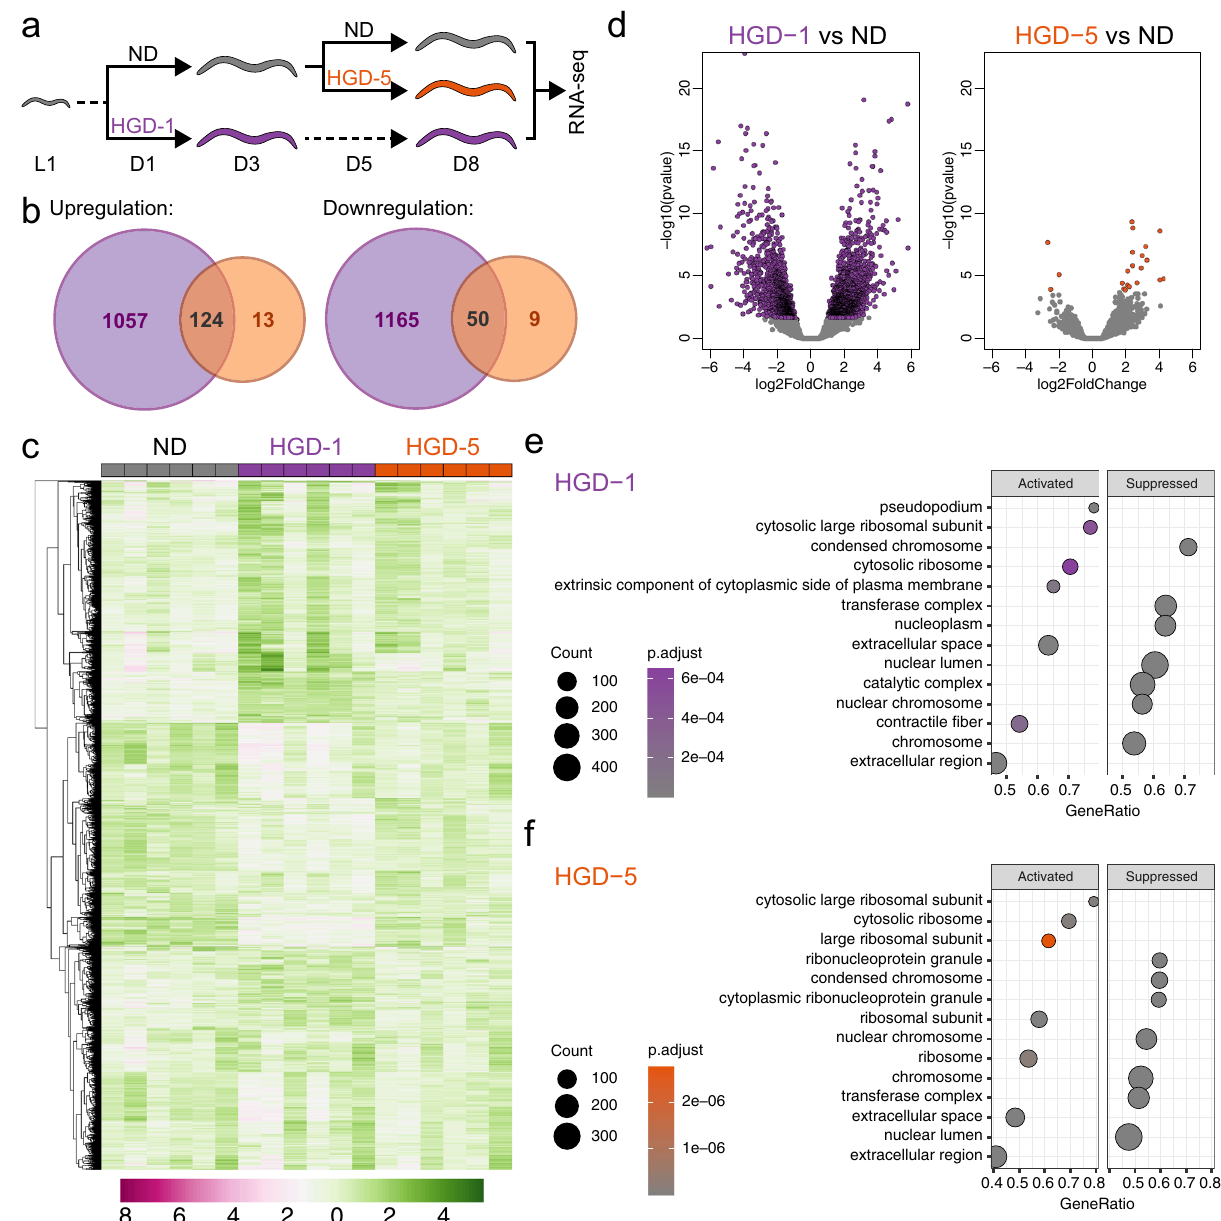
Fig. 2 | HGD induces global transcriptomic changes in young but not aged animals. a Experimental design of bulk RNA-seq. A single pool of synchronised wormswasgrownonNDuntilday1ofadulthood(D1).Fromthesamesinglepool,a subset of worms was fed on HGD at day 1 (HGD-1). The second subset of worms grown on ND was fed on HGD at day 5 (HGD-5) of adulthood (D5). Wrms fed ND, HGD-1, and HGD-5 were harvested at D8 ( n =6). b Venn diagram represents